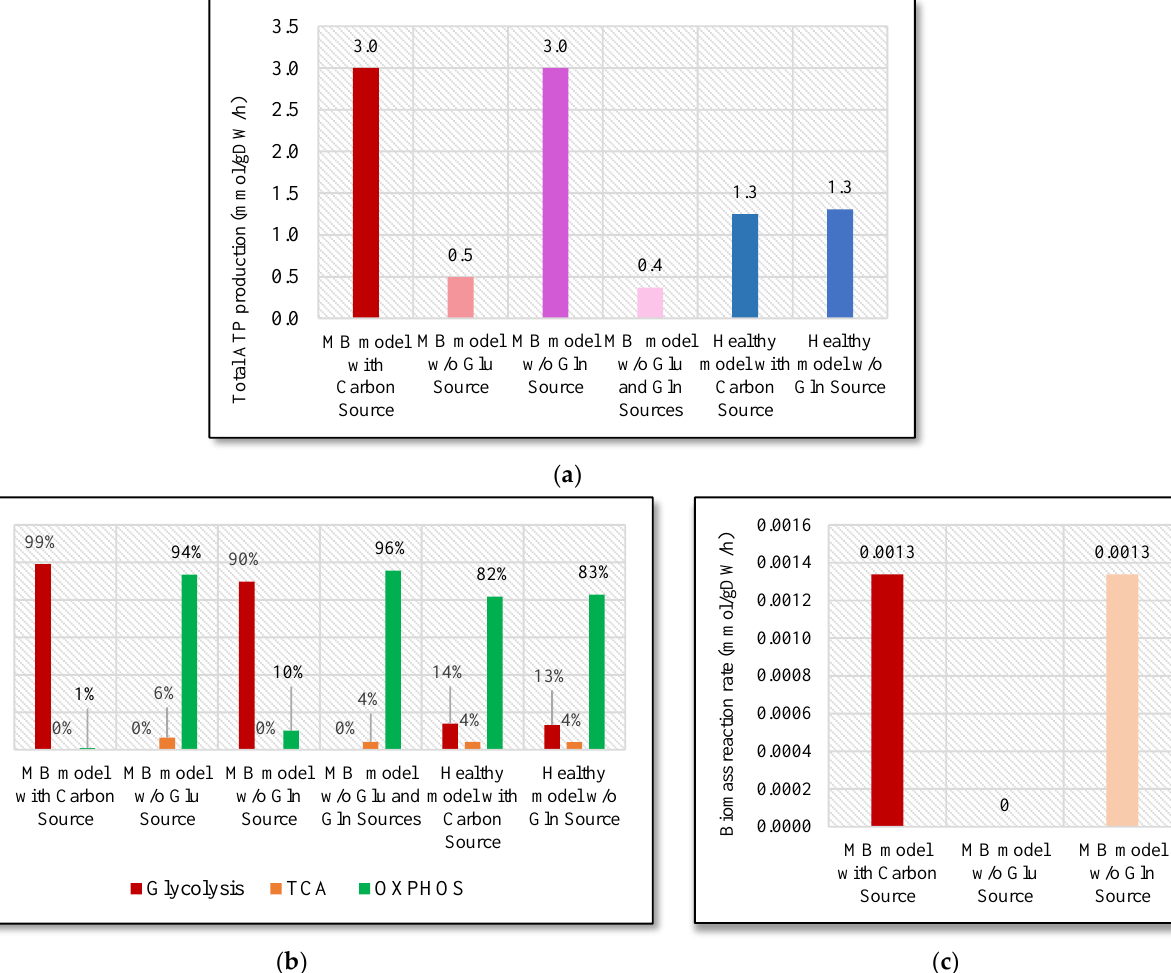
Figure 2. ( a ) Changes in total ATP generation rate; ( b ) Biomass reaction rate; ( c ) Energy generation distribution with respect to glucose (Glu) and/or glutamine (Gln) deficiencies in MB and healthy models.